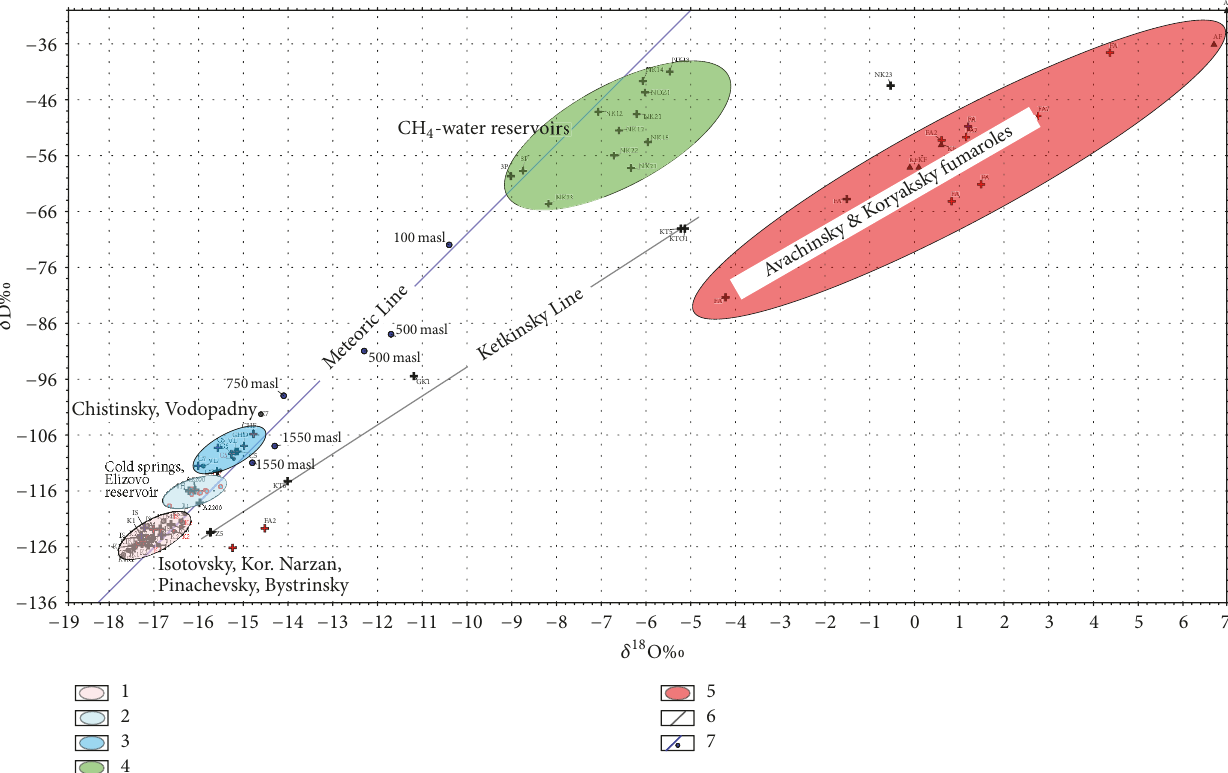
Figure 5: Isotopic compositions of water ( 𝛿 D and 𝛿 18 O). ( 1 ) Cluster of hot mineral springs (Isotovsky, Koryaksky Narzan, Pinachevsky, total of 36 samples, 2010–2016) and Bystrinsky cold groundwater reservoir (7 samples from 2010–2016); (2) one cold spring at a foothill of AvachinskyVolcano(2200 masl)andElisovocoldgroundwaterreservoir(7samples,2014–2016);(3)clusterofhotmineralsprings(Chistinsky, Vodopadny, total of 4 samples, 2014–2016) and cold springs at a north foothill of Koryaksky Volcano (total of 7 samples, 2010–2016); (4) water phase from Western Kamchatka CH 4 -water reservoirs (Kshuksky, Nizhne-Kvakchiksky, total of 12 samples, 2010–2016); (5) water condensate from Avachinsky and Koryaksky Volcano fumaroles (14 samples, 1997, 2010–2016); (6) Ketkinsky geothermal field line (5 samples, 2014); (7) Kamchatka representative sites of meteoric water samples (with elevations, masl) and meteoric line. Sampling was performed by A. Kiryukhin (1–7), T. Rychkova (6), Y. Taran (5), N. Malik (5), and P. Voronin (3). Analyses of samples were performed by P. O. Voronin and A. Y. Polyakov using an LGR IWA 45EP isotopic